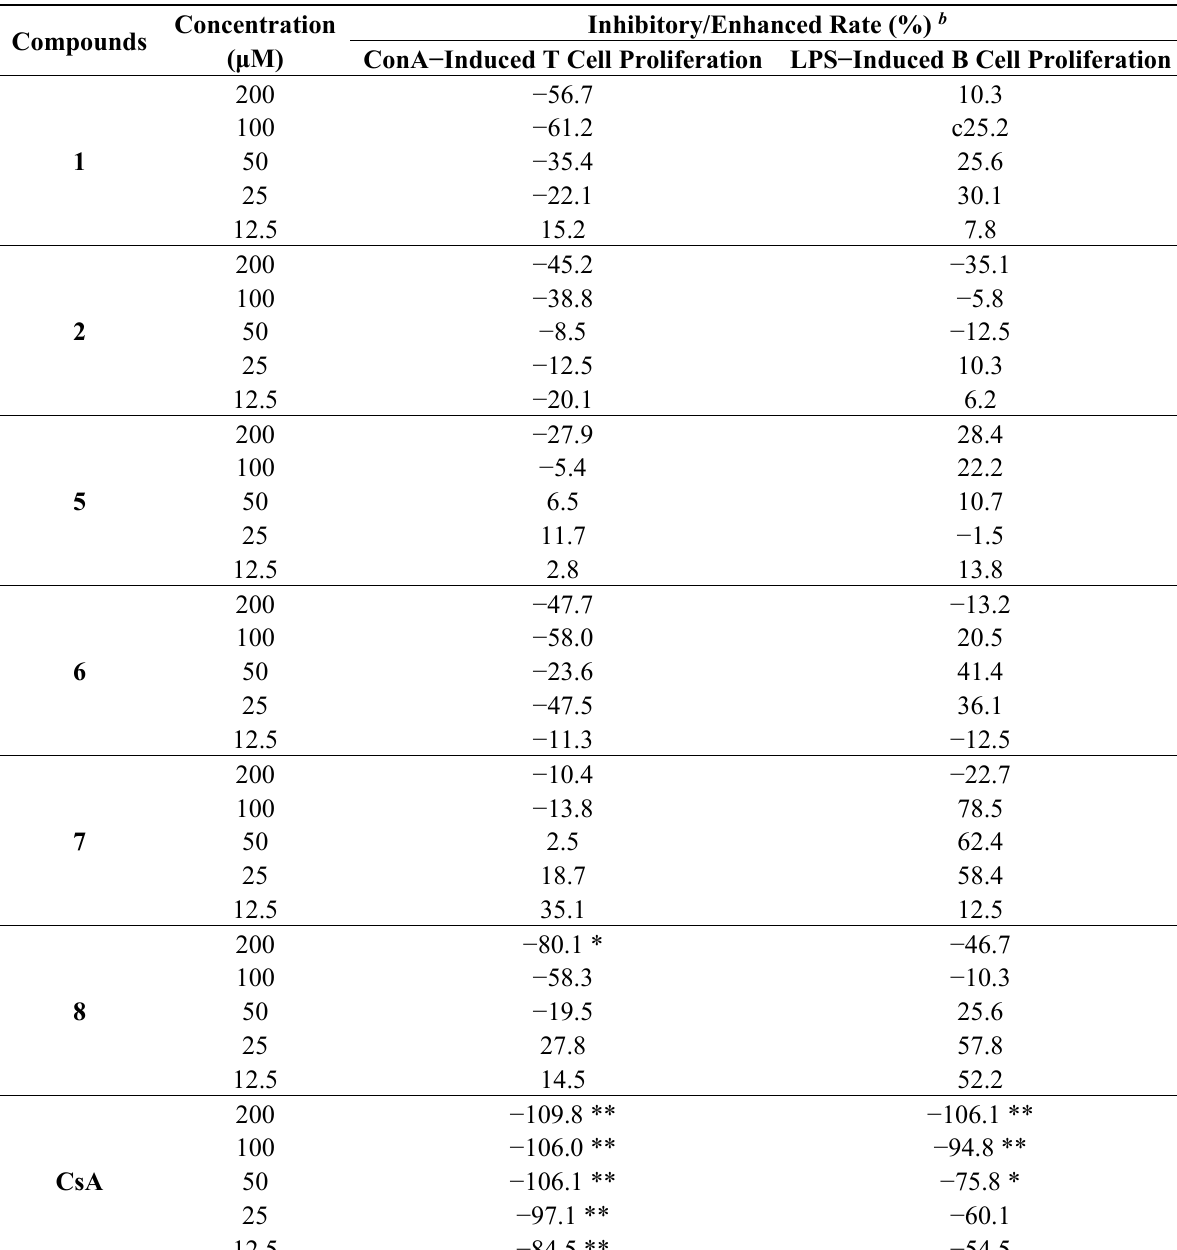
Table 2. Effects on Murine Lymphocyte Proliferation Induced by Concanavalin A (ConA) (5 μ g/mL) or Lipopolysaccharide (LPS) (10 μ g/mL) of the Selected Compounds 1 , 2 , and 5 – 8 a